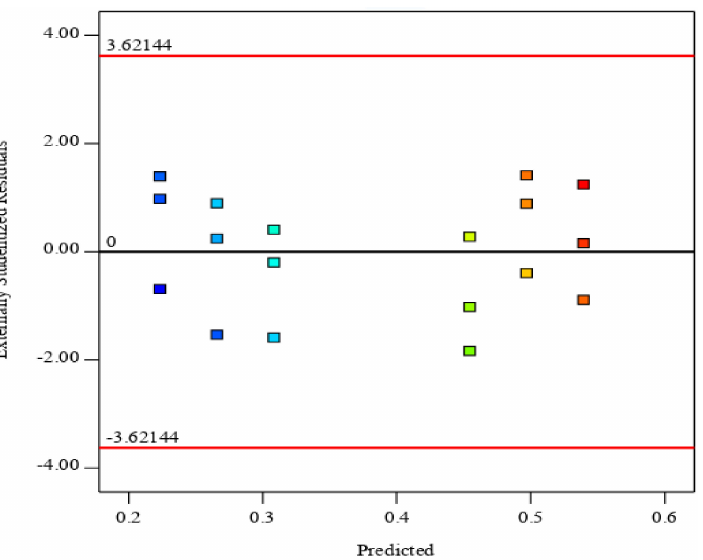
Figure 12. Plot of the externally residuals versus predicted values of the linear model. To check the assumption of independence in the linear regression, a plot of the externally studentized residuals versus the run number is worthwhile. The residuals versus run number plot is used to detect autocorrelation between disturbances. Autocorrelation occurs when the residuals have a pattern where they remain positive or negative. As shown in Figure 13, there was no autocorrelation among the disturbances, since the residuals randomly transitioned between positive and negative values, which indicates that the dependent variable of accumulated strain was not